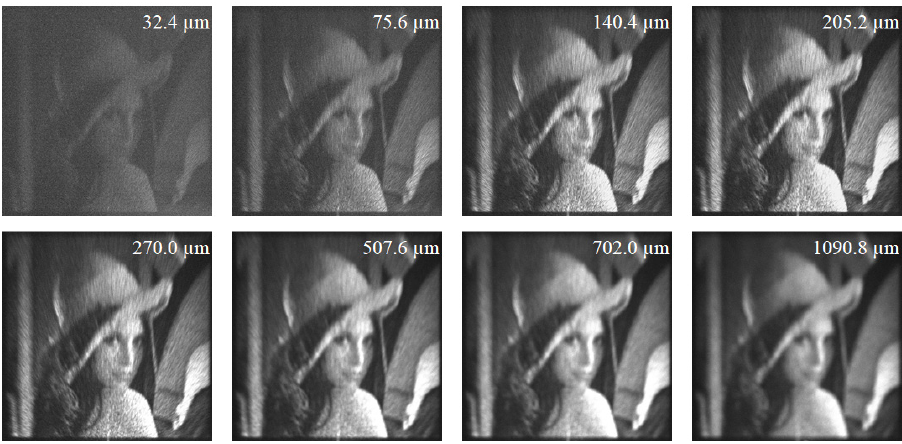
Figure 3. Reconstruction images of Fourier hologram depending on the various sizes of the spatial filter with 32.4, 75.6, 140.4, 205.2, 270.0, 507.6, 702.0, and 1090.8 µ